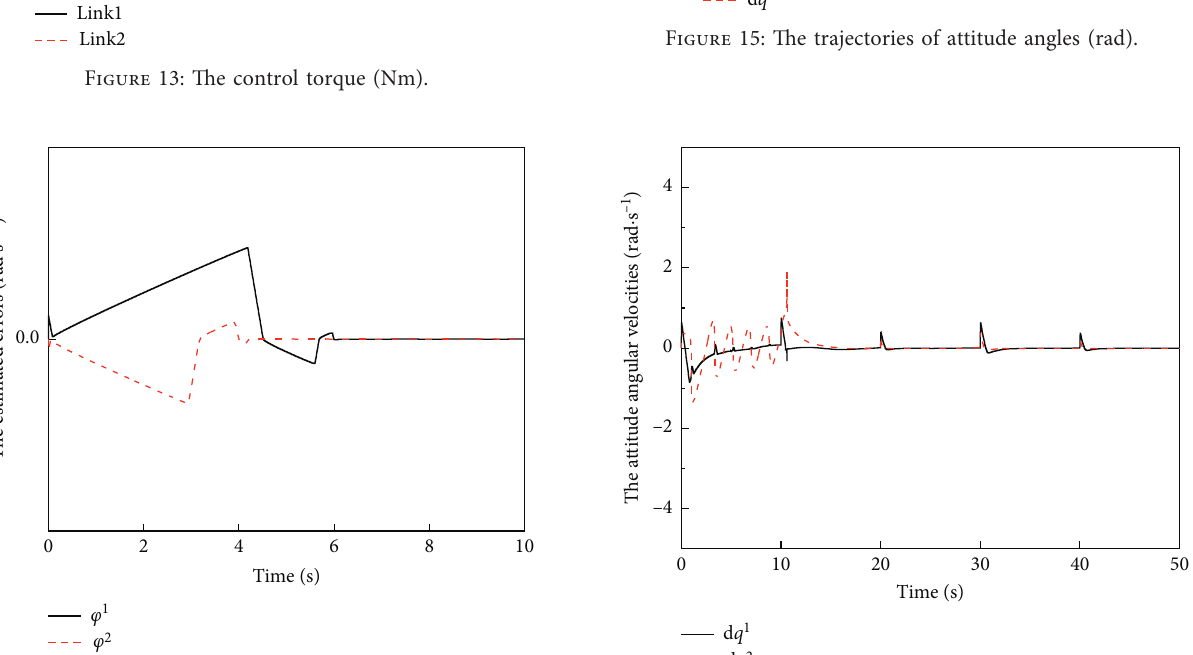
Figure 14: The estimated errors of FTISMDO (rad/s).